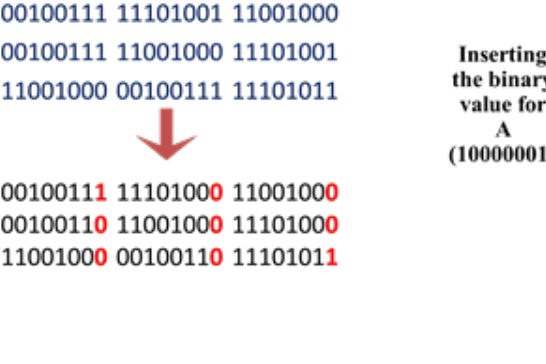
Figure 3 .A sample raster data for three pixels